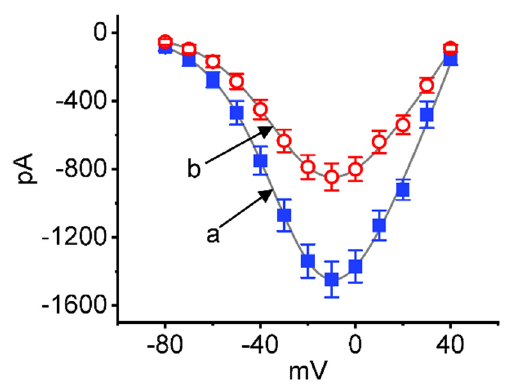
Figure 2. Effect of CBZ on the steady-state current versus voltage ( I–V ) relationship of I Na(T) identified in Neuro-2a cells. In these experiments, we voltage-clamped each cell at − 80 mV, and various depolarizing command voltages from − 80 to +40 mV in 10 mV increments were applied to evoke I Na . Current amplitude at each depolarizing pulse was taken at the beginning of the voltage pulse. a (Filled blue squares): control (i.e., absence of CBZ); b (open red circles): in the presence of 30 μ M CBZ. The smooth gray line over which the data points were overlaid was approximately fitted with a Boltzmann function as elaborated in Section 4.